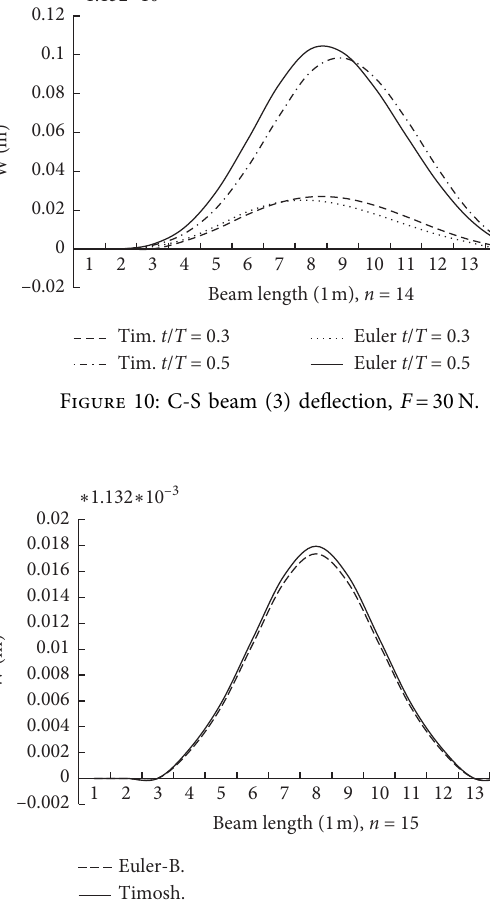
Figure 8: C-S T Beam (1) deflection, F � 30N.